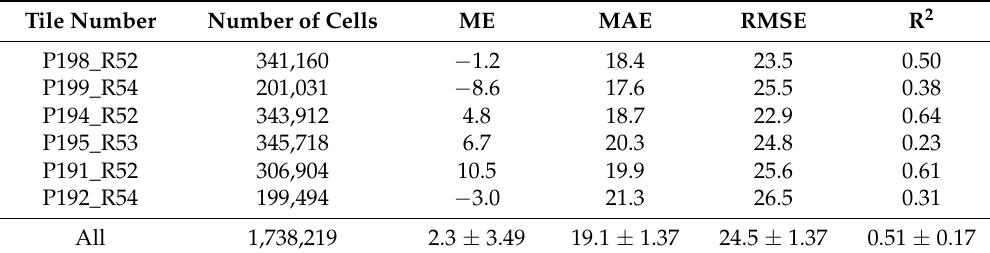
Table 3. Performance statistics of the MODIS fractional cover map